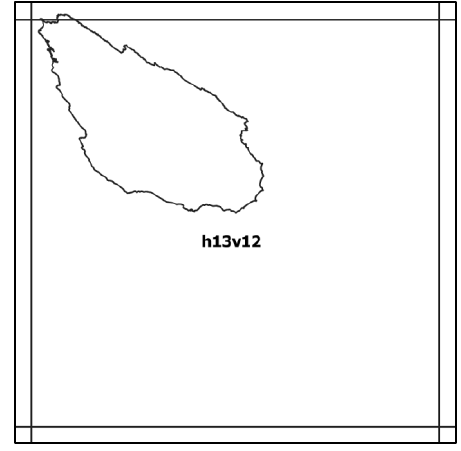
Figure 2. MODIS sinusoidal tile grid h13v12.